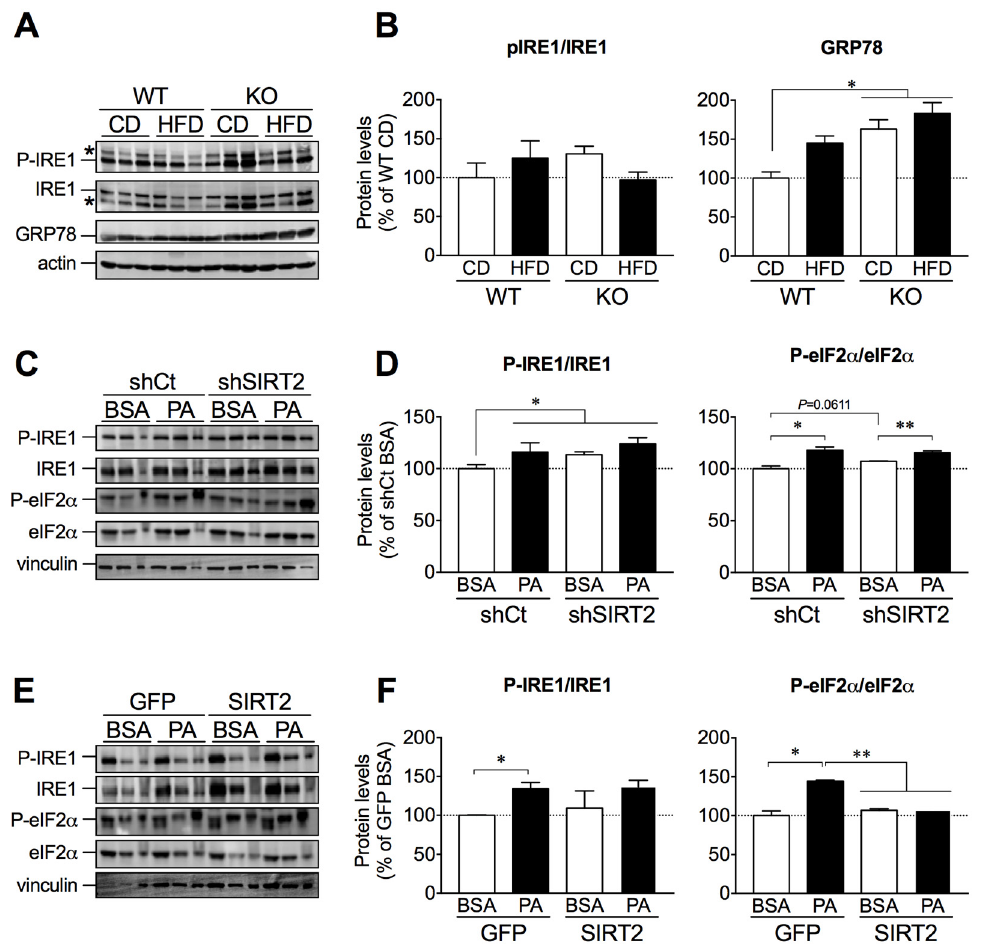
Figure 6. SIRT2 overexpression blunted palmitate-induced ER stress activation. ( A ) Representative Western blots of liver lysates showing P-IRE1 (Ser724), IRE1, and GRP78 levels from WT and SIRT2- KO mice fed a CD or HFD. ( B ) In the same lane, levels of P-IRE1 (Ser724) were normalized to IRE1, while GRP78 levels were normalized to actin. Values in the graph were normalized for the control condition (WT CD). n = 5–6 per group. ( C ) Representative Western blots of P-IRE1 (Ser724), IRE1, P-eIF2 α (Ser51), and eIF2 α of control HepG2 cells or SIRT2-silenced cells treated with BSA (vehicle) or palmitate (0.5 mM) for 24 h. ( D ) In the same lane, levels of P-IRE1 (Ser724) and P-eIF2 α (Ser51) were normalized to IRE1 and eIF2 α , respectively. Values in the graph were normalized for the control (shCT BSA). n = 3 per group. ( E ) Representative Western blots of P-IRE1 (Ser724), IRE1, P-eIF2 α (Ser51), and eIF2 α of control HepG2 cells or SIRT2-overexpressing cells treated with BSA (vehicle) or palmitate (0.5 mM) for 24 h. ( F ) In the same lane, levels of P-IRE1 (Ser724) and P-eIF2 α (Ser51) were normalized to IRE1 and eIF2 α , respectively. Values in the graph were normalized for the control (BSA GFP). n = 3 per group; * p < 0.05, ** p <